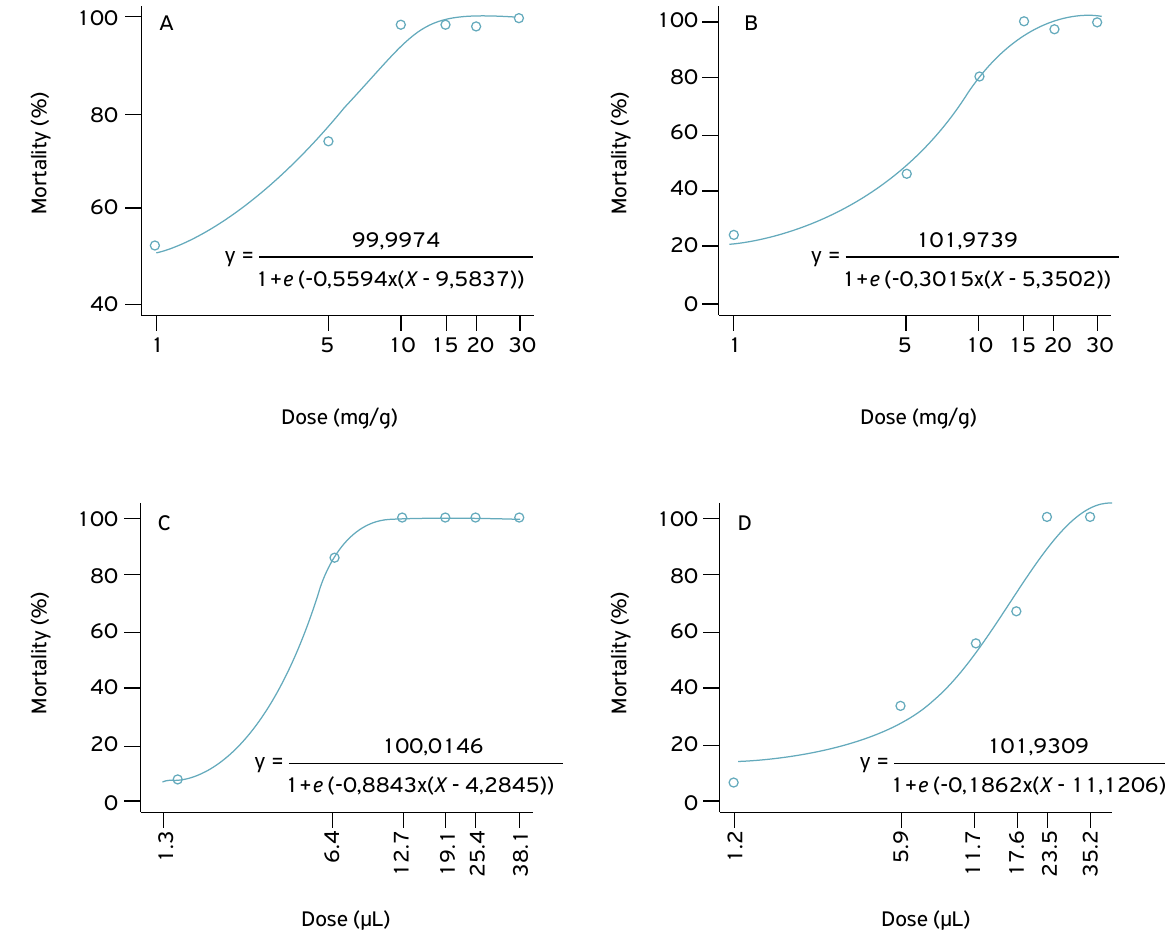
Figure 2. Mortality (%) of second-instar caterpillars Spodoptera frugiperda 10 days after topical application obtained with topical applications of different dosages of essential oils of Corymbia citriodora (A) and Lippia microphylla (B) and under volatile effect Corymbia citriodora (C) and Lippia microphylla